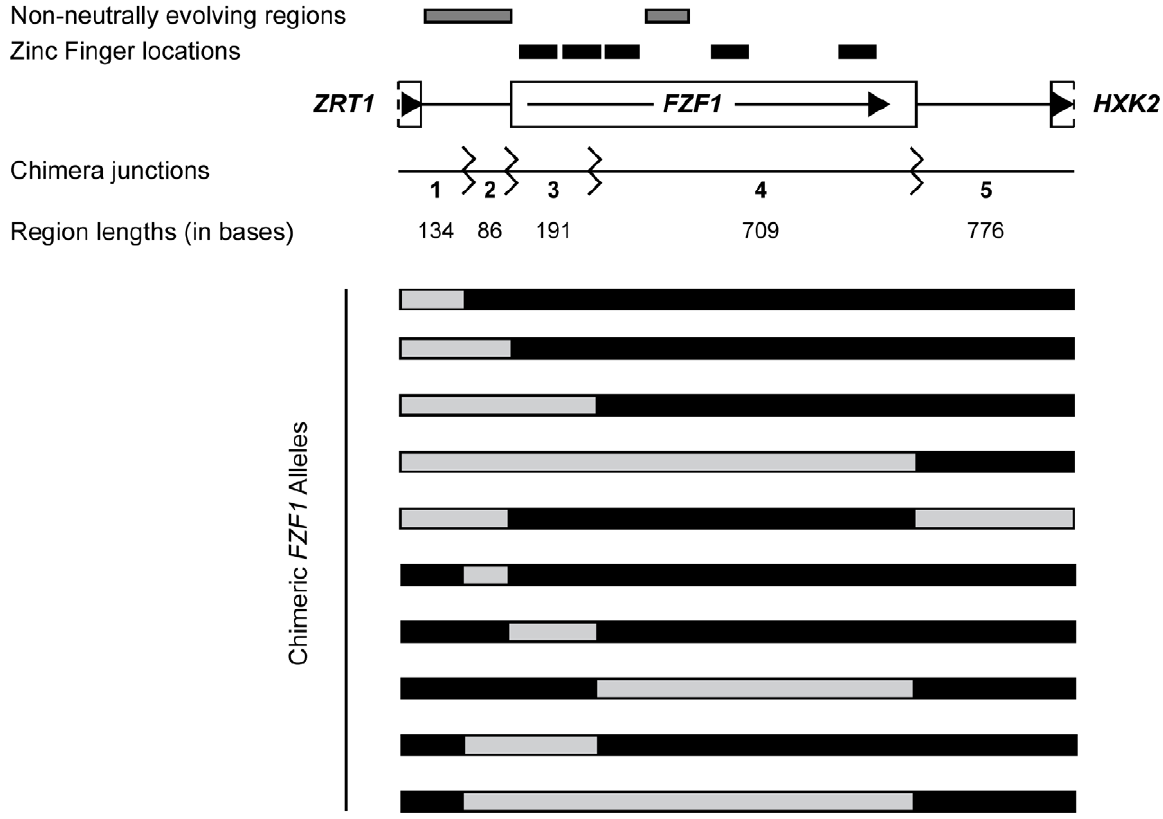
Figure 3. FZF1 gene region and chimeric alleles. The FZF1 gene region is shown along with the breakpoints used to generate reciprocal chimeric alleles. Regions with non-neutral evolution are indicated by gray boxes and the predicted zinc fingers are indicated by black boxes [73]. Region lengths between chimera junctions are given for S. cerevisiae . One set of chimeric alleles between S. cerevisiae and S. paradoxus are shown below. The reciprocal set is not shown.